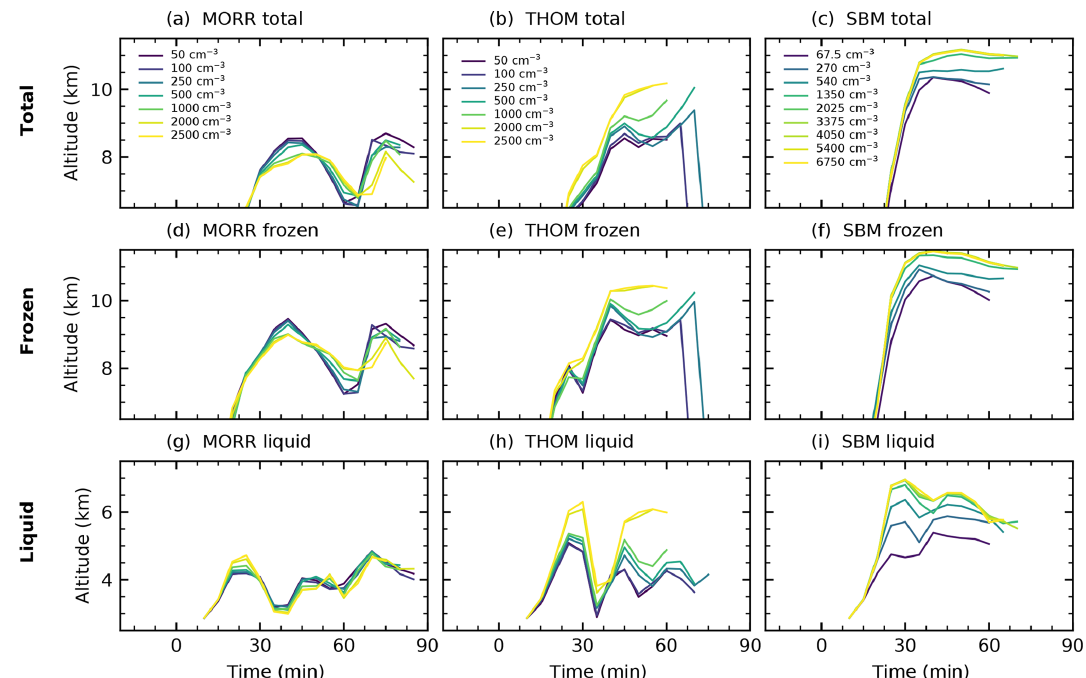
Figure 16. Altitude of the centre of gravity of the cloud and the individual phases in the analysed left-moving cell for the three different microphysics schemes (Morrison: a , d , g , Thompson: b , e , h , SBM: c , f , i ) in